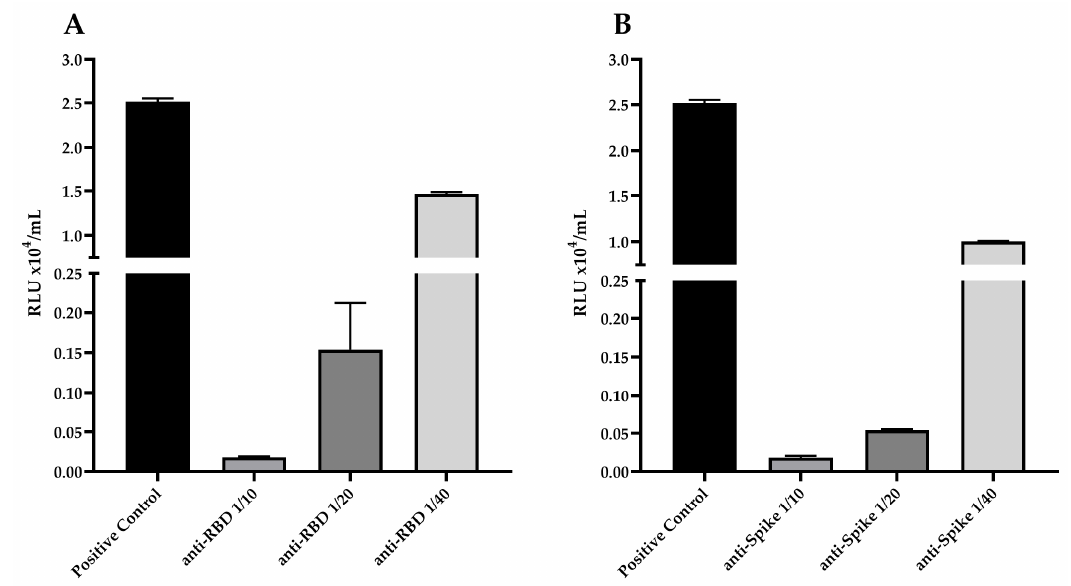
Figure 6. Serum neutralization of SARS-CoV-2 pseudoviruses particles. Two-fold serially diluted (from 1:10 to 1:40) solutions of ( A ) anti-RBD or ( B ) anti-spike serum were incubated with pseudoviruses with titers of approximately 10 4 RLU/mL of luciferase activity for one hour at 37 ◦ C. Pseudovirus infectivity was assessed using the Luciferase Assay. Pseudovirus neutralization titers are expressed as